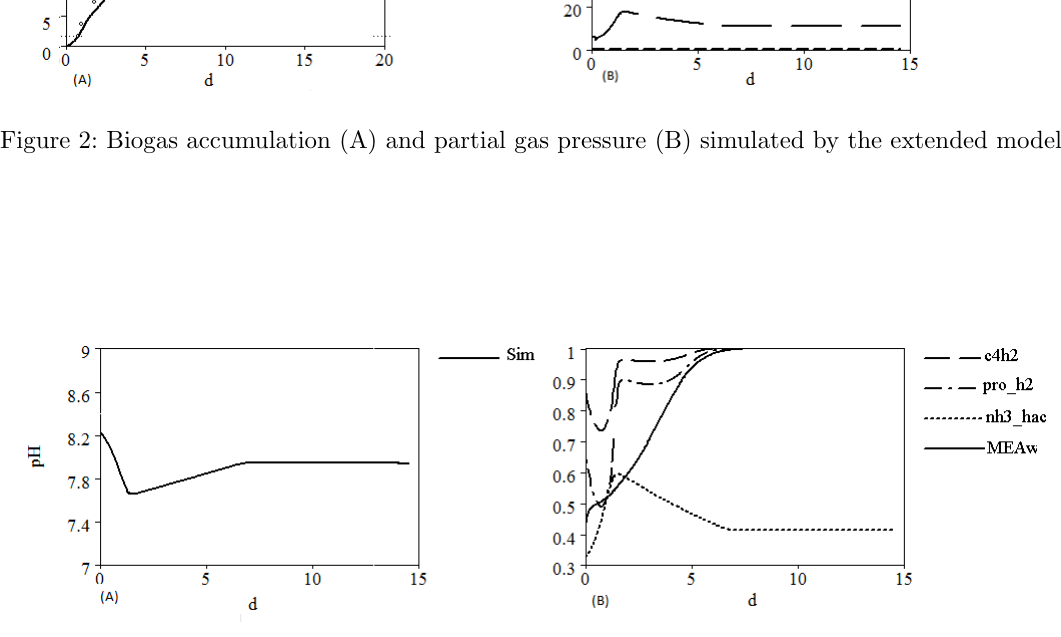
Figure 3: Simulated pH (A) and inhibition effects (B), c4h2, pro h2, nh3 hac and MEAw are inhibitions of hydrogen on butyrate, propionate degradation, free ammonia and MEAw on acetate degradation, respectively